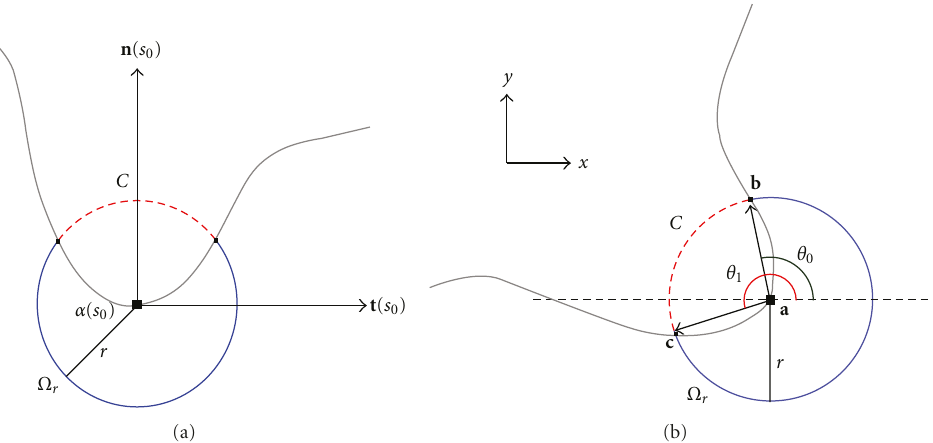
Figure 1: (a) For a point (the black square dot) on a curve g ( x ) (the gray line), we draw a circle Ω r centered at that point. The integral region C = { ( x , y ) | x 2 + y 2 = r 2 , y ≥ g ( x ) } is denoted by red dashed line. It is convenient to write the equation of the curve, in the neighborhood of α ( s 0 ), using t ( s 0 ) and n ( s 0 ) as a coordinate frame. (b) After obtaining θ 0 and θ 1 , the line integrals can be easily computed. It does not matter which coordinate system we use for computing θ 0 and θ 1 . One can always obtain a curvature estimate by performing eigenvalue decomposition.